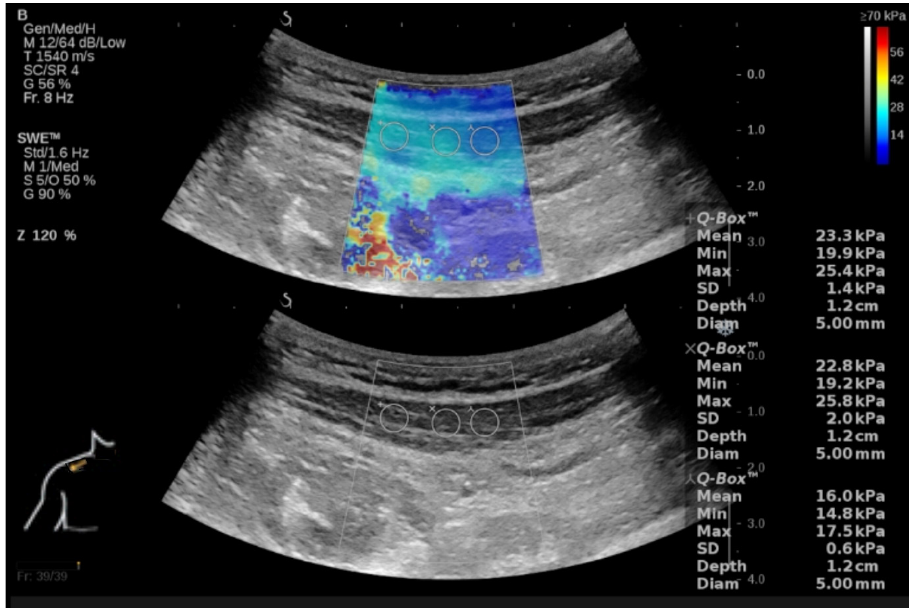
Fig. 2. Measuring stiffness of the trapezius muscle with a convex probe in a healthy volunteer. The image depicts three ROIs in one of the two assessments of the trapezius